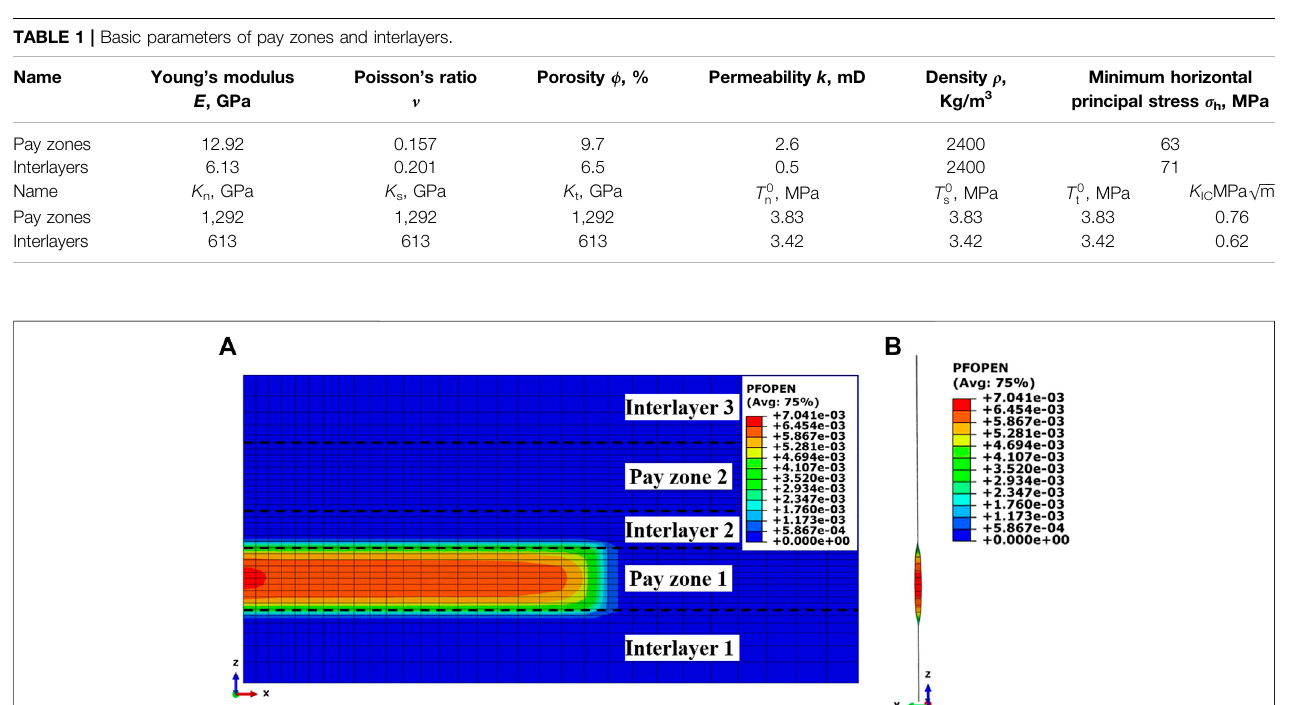
Frontiers in Earth Science |